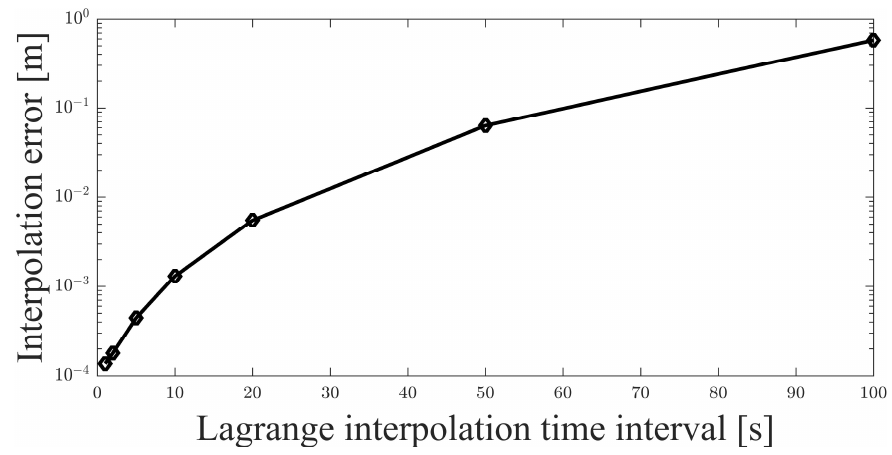
Figure 8. Lagrange interpolation result of inter-satellite distance.